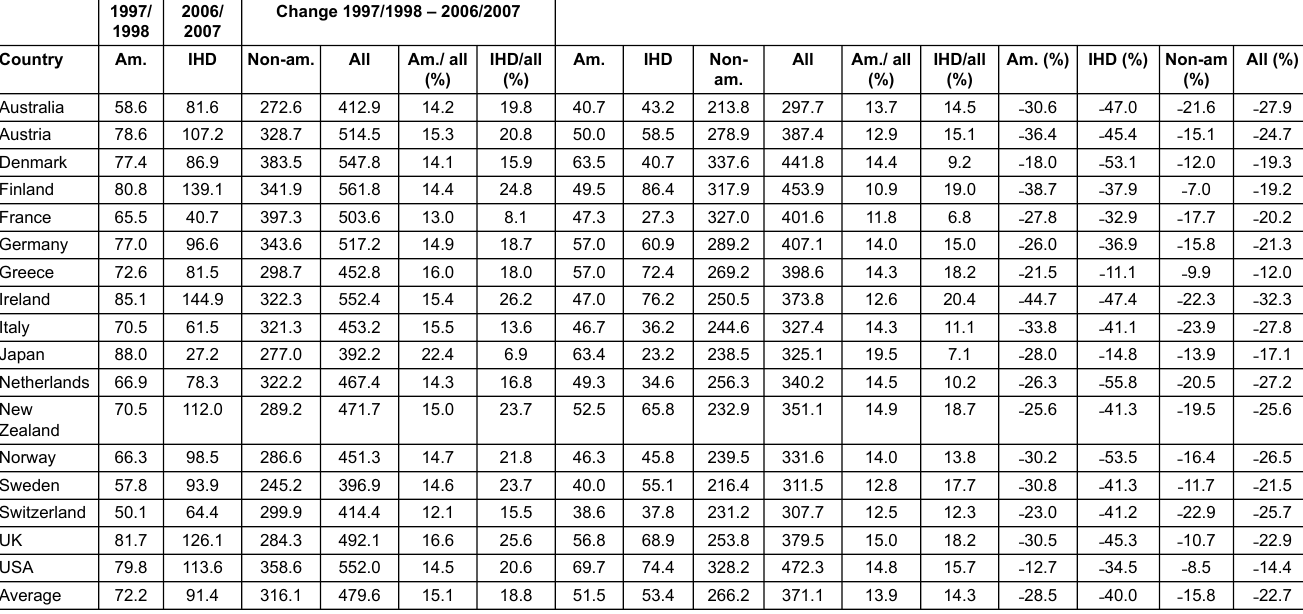
1997/ 2006/ Change 1997/1998 – 2006/2007 1998 2007